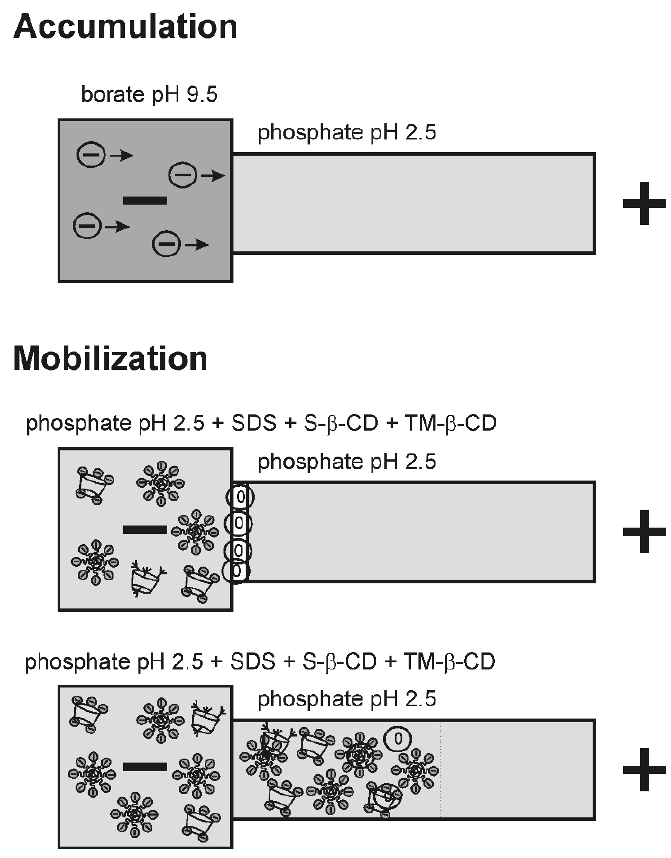
Figure 2. Schematic representation of the on-line electrokinetic accumulation/mobilization preconcentration